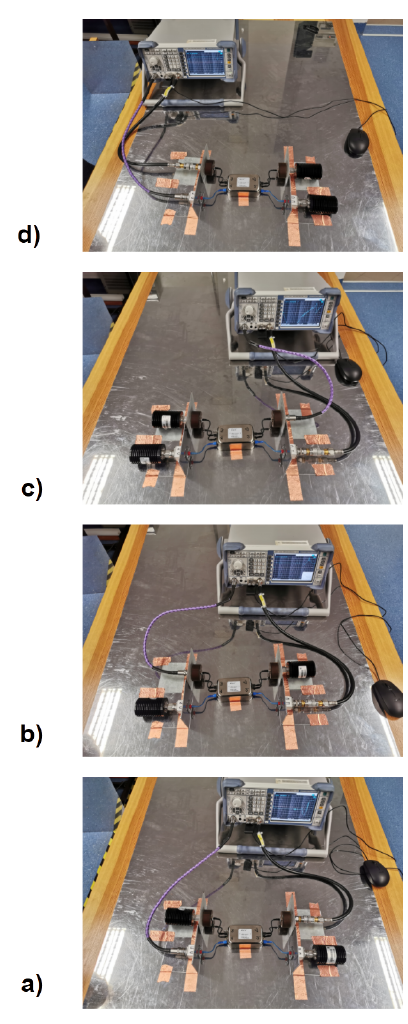
Figure 8. The test setup for the measurement of the single-path S-Parameters of the exemplary filter for the following single paths: 1-4 ( a ), 2-3, ( b ), 2-4 ( c ), and 1-3 ( d